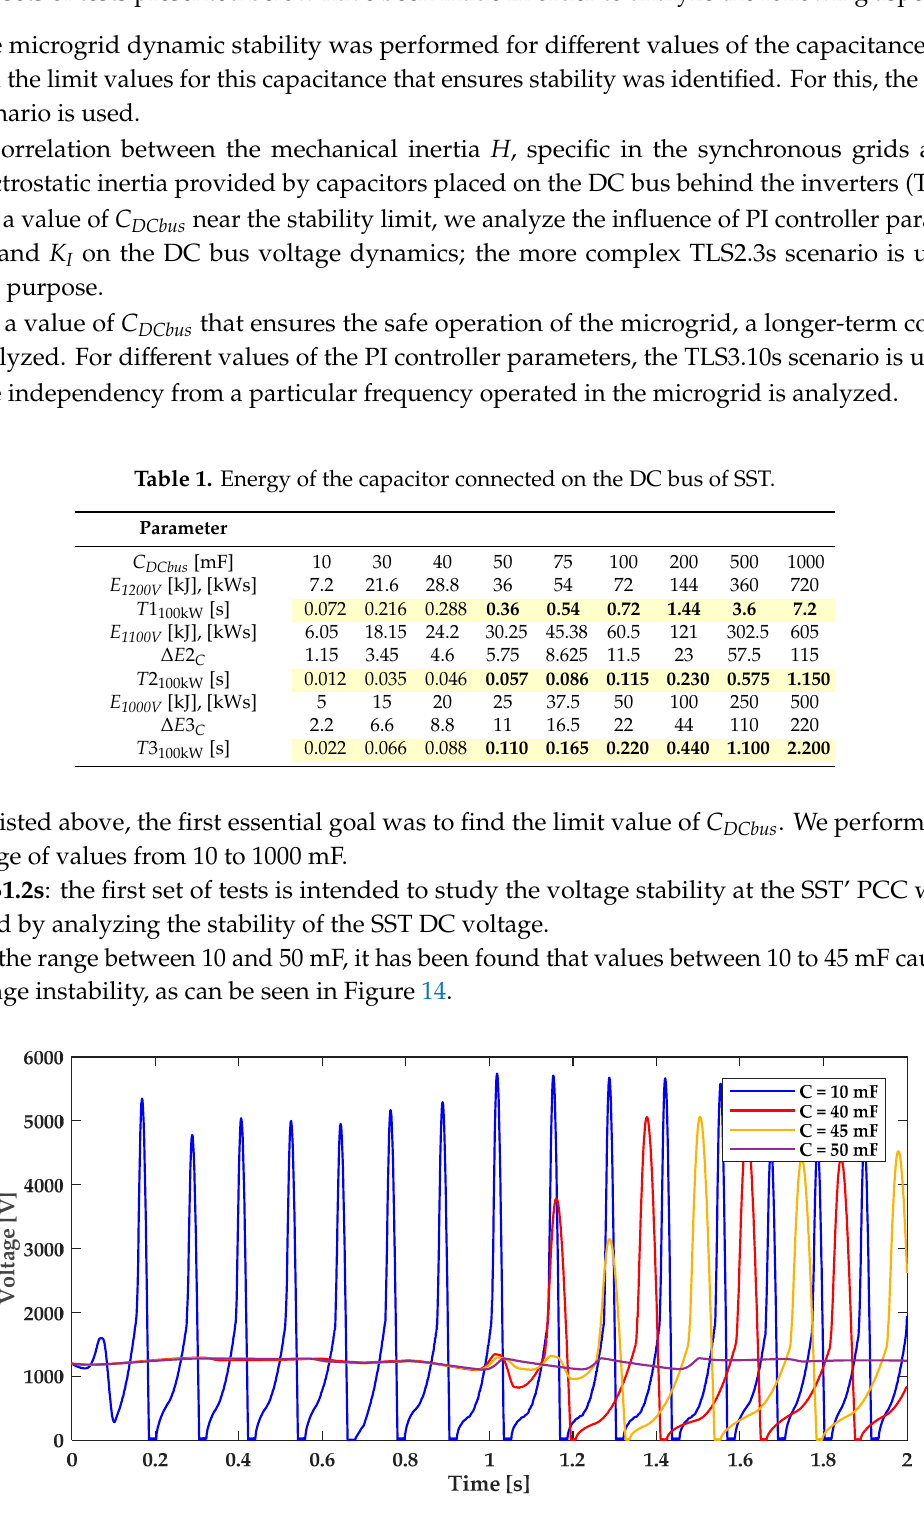
Figure 14. Stability of DC bus voltage in SST, for values of C between 10 and 50 mF.